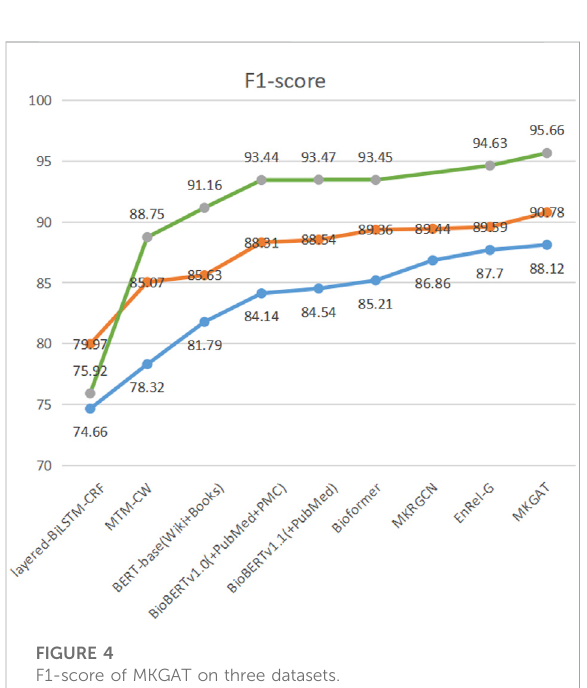
FIGURE 4 F1-score of MKGAT on three